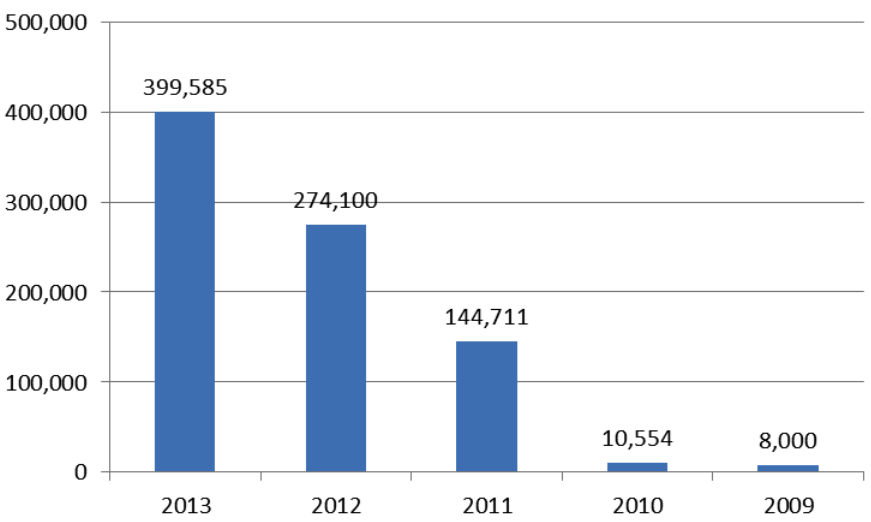
Figure 1 . Visitors to Psychosocial Intervention Website: